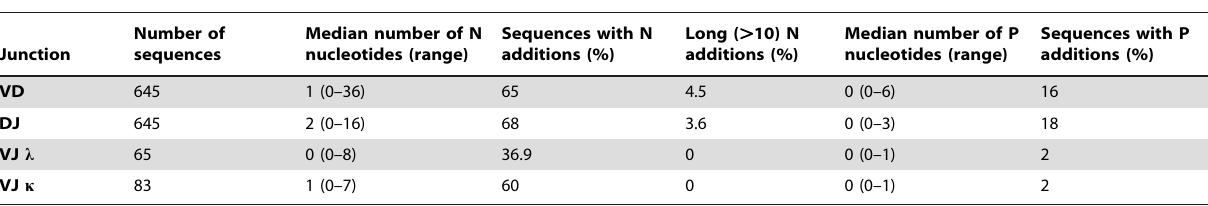
Table 5. Analysis of nucleotide additions in bovine fetal IGH (bone marrow), IGL and IGK (bone marrow and ileum).